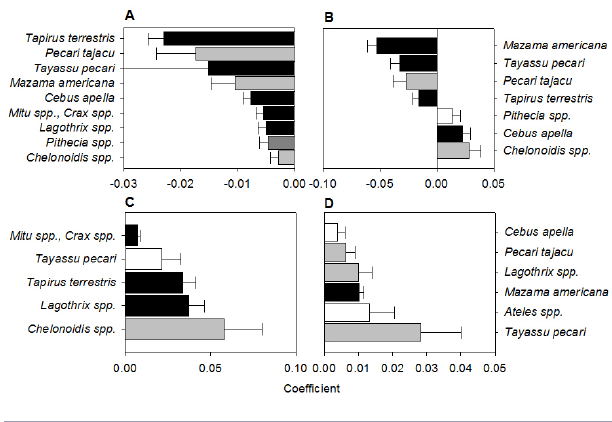
Fig. 3 . Coefficients from minimal generalized linear models (GLMs) of depletion distances of hunted vertebrates around 161 Amazonian settlements for the following predictor variables: (A) Travel distance from nearest urban settlement (km); (B) Percentage of terra firme upland within a 5 km radius; (C) Number of households in the settlement; (D) Human population density (people km-2) within a 5-km radius. Shading indicates significance levels (black: p < 0.001; dark gray: p < 0.01; light gray: p < 0.05; white: p < 0.1).